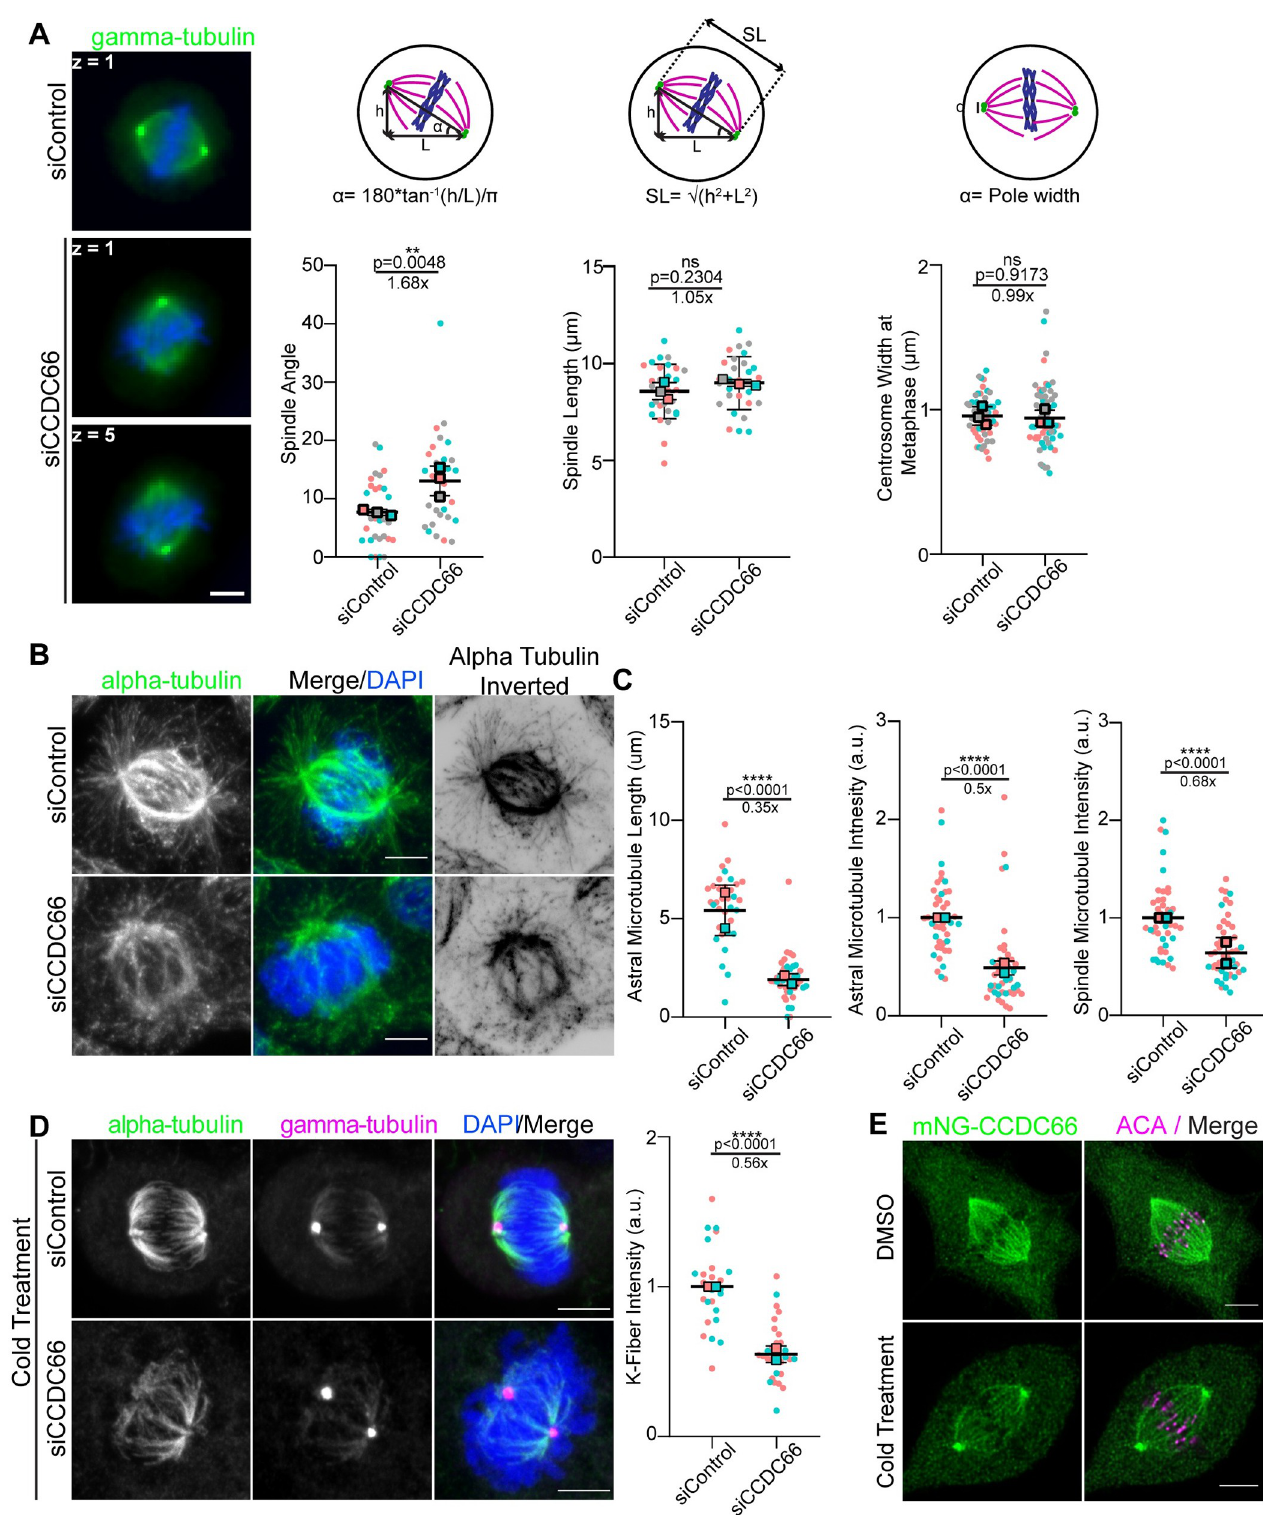
Fig 4. CCDC66 regulates spindle organization and orientation. (A) Effects of CCDC66 depletion on spindle angle, length, and pole width. U2OS cells were transfected with control and CCDC66 siRNA, fixed with methanol and stained for gamma-tubulin; z on still images indicates the stack where the centrosome is found. Spindle angle is calculated by the formula α = 180 � tan − 1 (h/L)/ π where h represents the stack difference between 2 centrosomes, L represents the distance